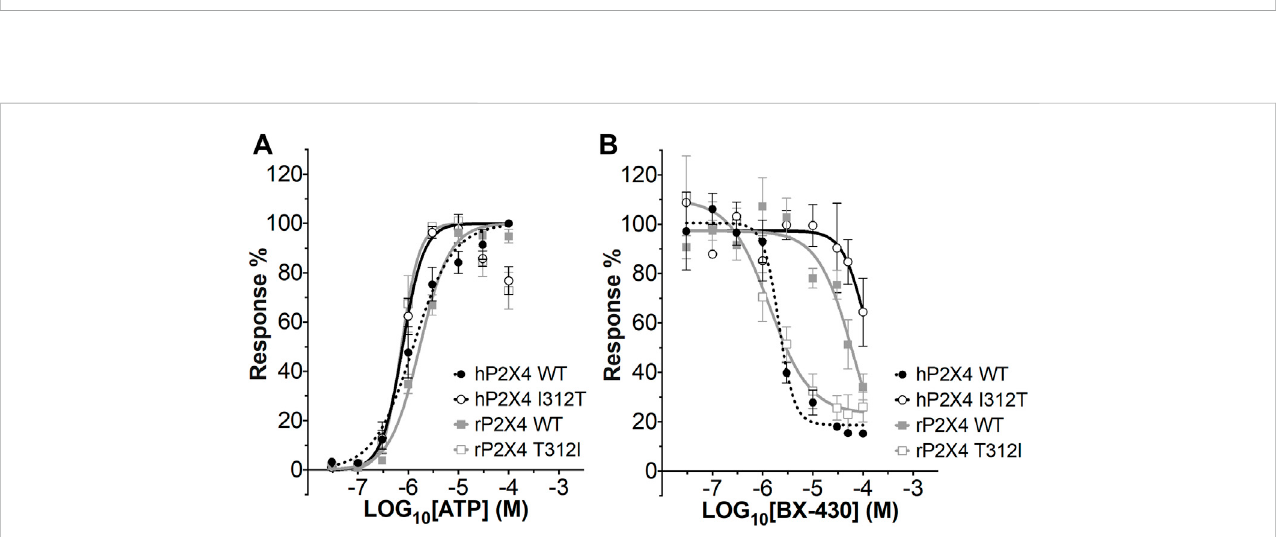
FIGURE 3 ATP concentration-response and BX430 concentration-inhibition curves for human and rat P2X4 (wild type and mutant) receptors. (A) . Mean ATP concentration-responsecurvesofratP2X4wildtype(rP2X4WT,greyfullsquares),ratP2X4T312Imutant(rP2X4T312I,grayemptysquares),humanP2X4wild type(hP2X4WT,blackfullcircles),humanP2X4I312T(hP2X4WT,blackemptycircles).Responsesrepresent fl uorescenceincreasefollowingATPadditionand were normalized to the maximum response mean value recorded among the concentrations tested. Data merged from 3 or more independent experiments (4 – 6 technical repeats per experiment). Error bars are SEM. EC 50 and Hill coef fi cient values are reported in Table 2. (B) . Mean BX430 inhibition curves of rat P2X4 wild type (rP2X4 WT, grey full squares), rat P2X4 T312I mutant (rP2X4 T312I, gray empty squares), human P2X4 wild type (hP2X4 WT, black full circles), human P2X4 I312T (hP2X4 WT, black empty circles). Responses represent fl uorescence increase elicited by 1 µM ATP addition after incubation withincreasingconcentrationsofBX430.Data pointswerenormalizedto theresponseobtained withvehicle-only(0.1%DMSO)andarepresented asmean± SEM. Data merged from 2 (for hP2X4 WT) or more independent experiments (3 – 5 technical repeats per experiment). IC 50 and Hill coef fi cient values are reported in Table 3.